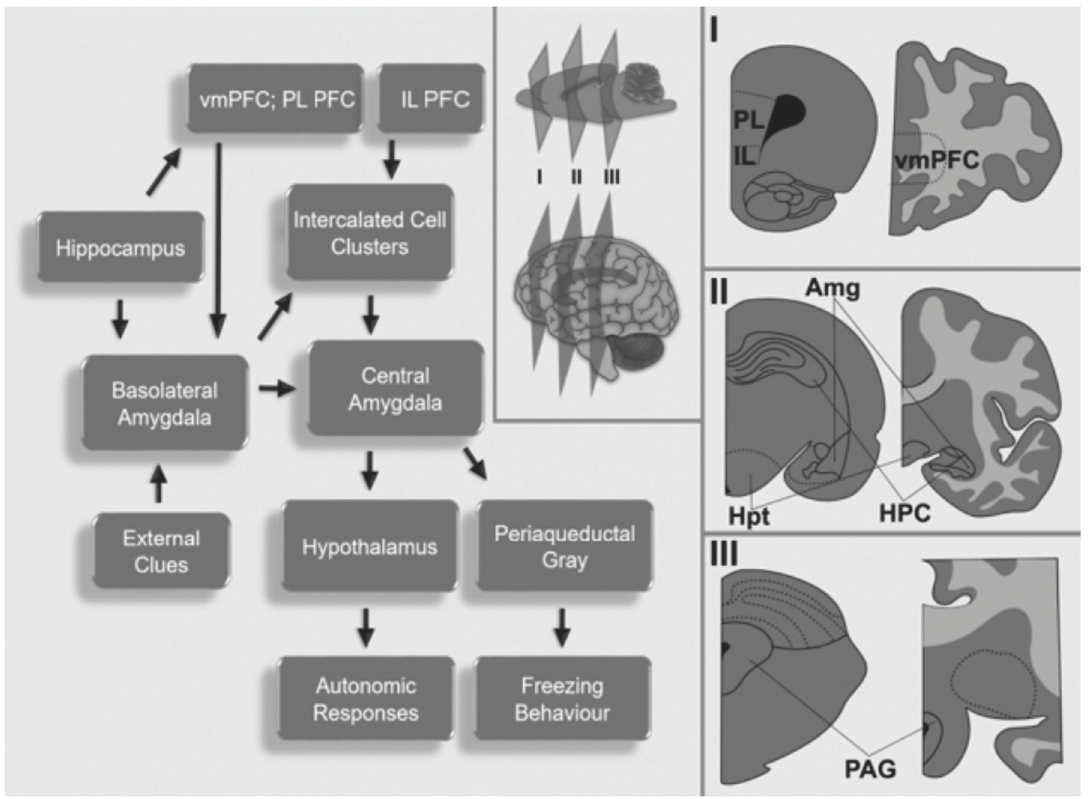
Figure 1. Schematic representation of the neurocircuitry involved in fear conditioning and extinction as well as post-traumatic stress disorder. I, II, and III represent the different coronal sections of rodents (left) and humans (right). Amg, amygdala; HPC, hippocampus; Hpt, hypothalamus; PAG, periaqueductal gray; PFC. Prefrontal cortex; vmPFC, ventromedial prefrontal cortex; IL, infralimbic cortex; PL, prelimbic cortex.